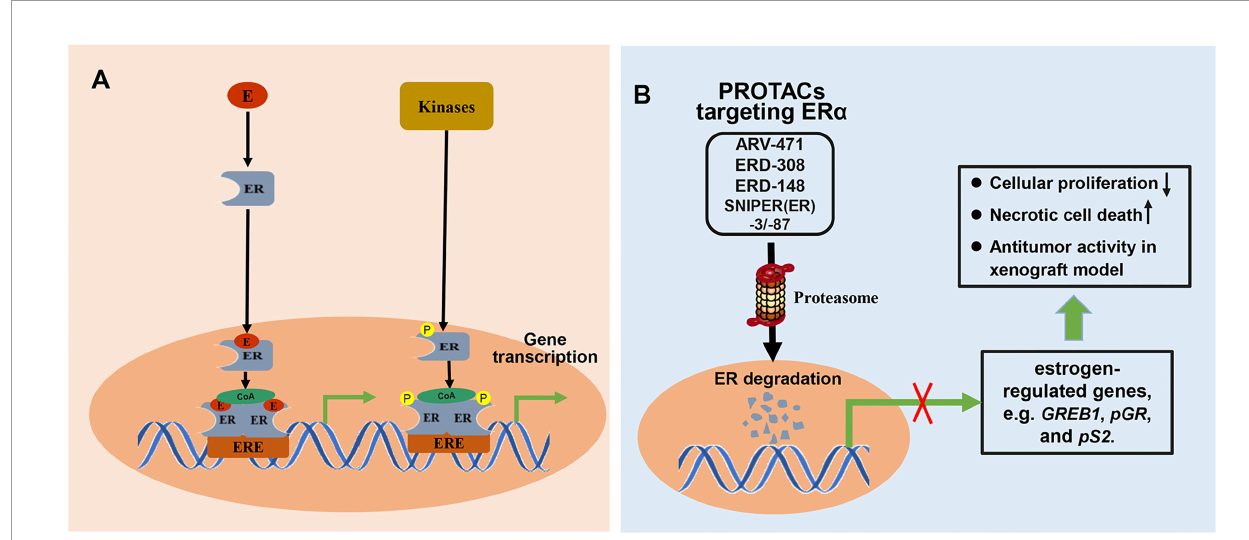
FIGURE 6 | The mechanisms involved in ER signal pathway and PROTACs targeting ER. (A) Classically, ligands, like estrogen (E), bind to the ER to form ligand- bound ER. ligand-bound ER dimerizes and binds to estrogen response elements (ERE), and then activates gene transcription after recruiting coactivator (CoA). Besides, ER can be phosphorylated by related kinases and regulates gene transcription in a ligand independent pathway. (B) PROTAC targeting ER can induce proteasome-mediated degradation of ER protein, and effectively suppress the mRNA levels of estrogen-regulated genes, which resulted in cell proliferation inhibition, induction of necrotic cell death, and signi fi cant antitumor activity in xenograft